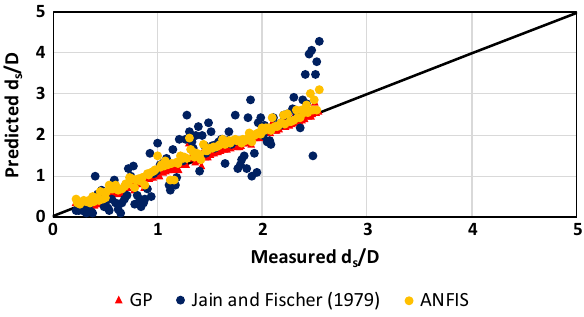
D versus Jain and Fis- s /